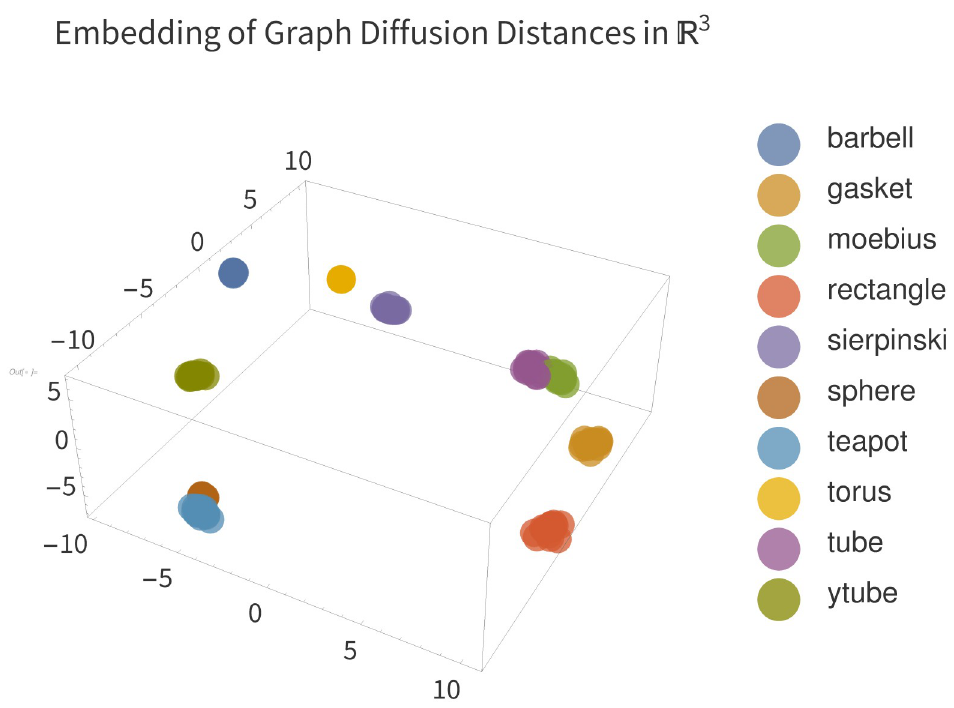
Fig 13. Embedding of pairwise distances between mesh discretizations. We see that GDD clusters each category of mesh tightly, and furthermore that clusters are nearby when they are structurally similar meshes, and distant otherwise. Axes represent the three principal components of the distance matrix and are thus